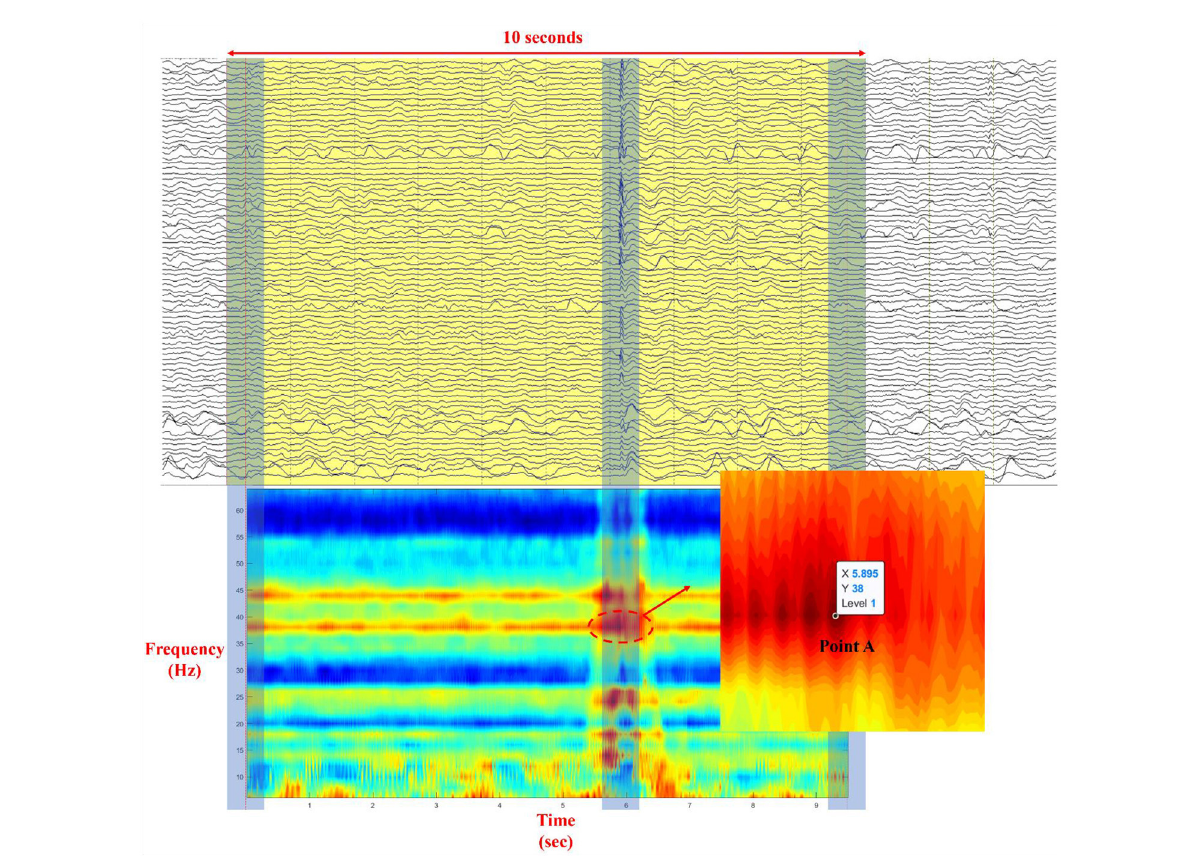
FIGURE2 Illustration of the process of selection of point A in a time–frequency plot (Each time–frequency point in the plot represents the level of phase synchrony at a specific time point and a given frequency; ECoG data was illustrated with a bandpass filter to provide cut–off frequencies between 0.5 and 66.6Hz and with a notch filter to provide cut–off frequency at